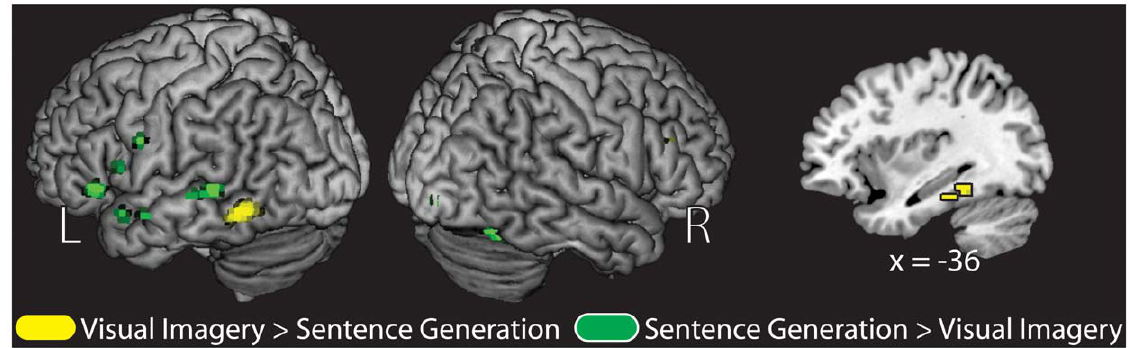
Figure 2. Main effect of instructed encoding strategy at study for trials with implementation success collapsed across subsequent associative memory judgments. Regions showing the effect of visual imagery (yellow; Visual Imagery . Sentence Generation) and the effect of sentence generation (green; Sentence Generation . Visual Imagery) are depicted. All regions displayed on a standard surface-rendered brain in MNI space. The left medial temporal lobe is shown through a sagittal slice at x= 2 36. Statistical threshold: p , 0.001, uncorrected, 5 contiguous voxels.